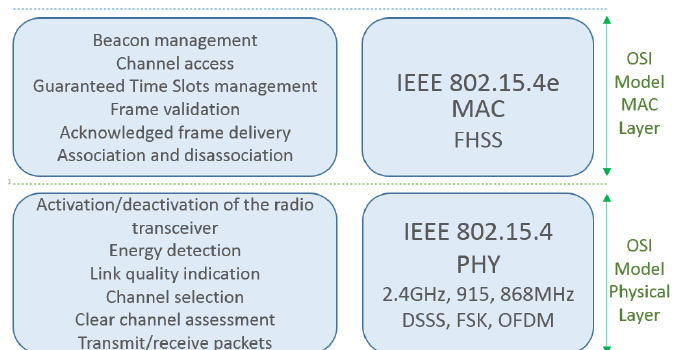
Figure 11. IEEE 802.15.4 compared with OSI reference